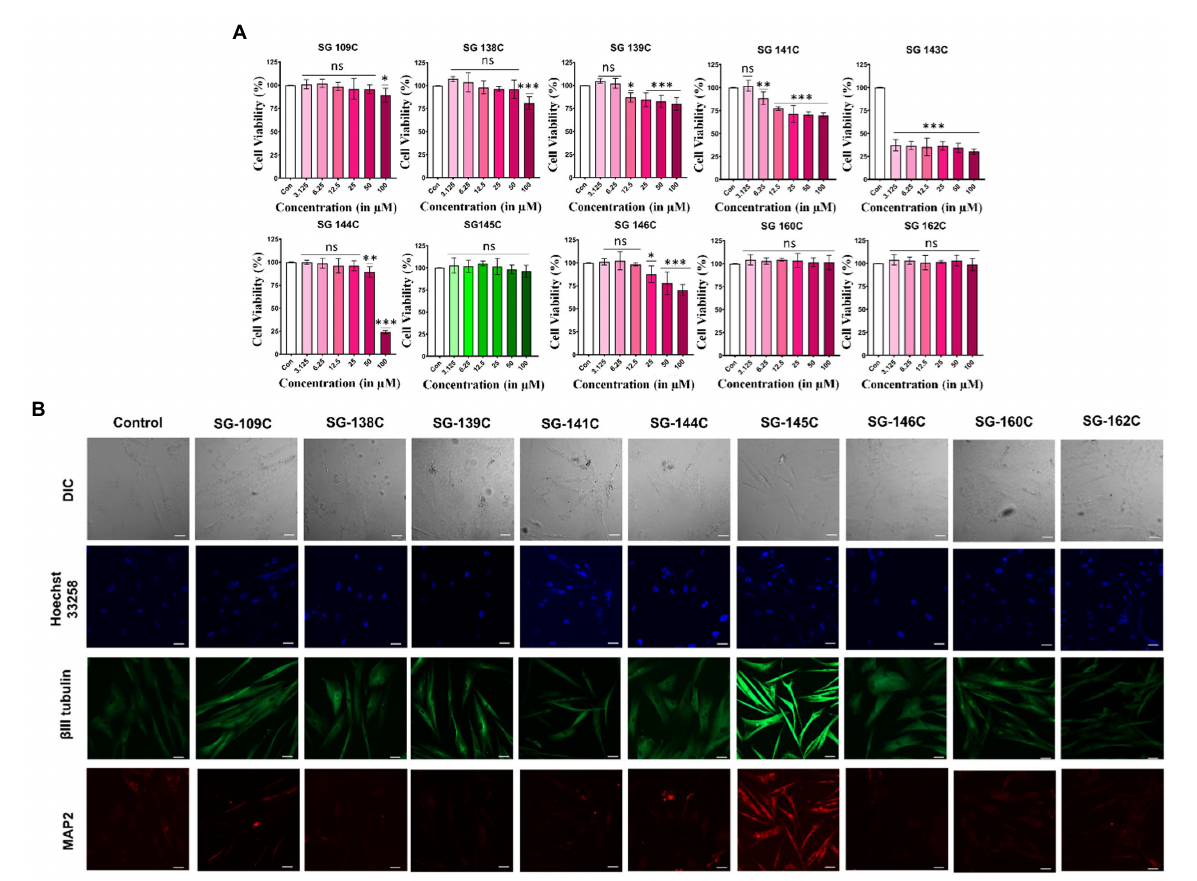
FIGURE 2 MTT and immunocytochemistry assay for identification of SG-145C as a lead molecule. (A) Percentage of cell survival after the treatment with the molecules in an increasing gradient of doses (3.125–100 μ M) for 24 h. n ≥ 3 in all data sets and significance was calculated using one-way Anova. (B) MSCs were treated with the small molecules for 7 days and neuron specific markers were observed using β -III Tubulin (AF-488) and Map2 (AF- 543) via immunocytochemistry. Images were captured in 20× magnification where the scale bar corresponds to 70 μ m. Significance was calculated using students unpaired t -test * p < 0.05, ** p < 0.01, *** p <